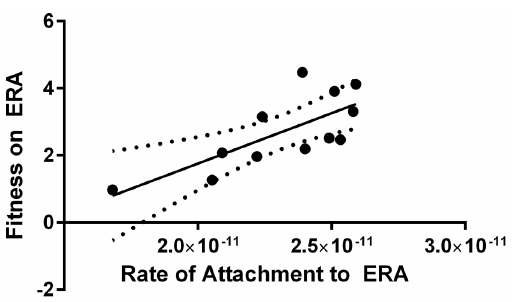
Figure 3. Mean ERA attachment rate (k) is plotted against phage 6 fitness on ERA. Attachment to ERA was correlated with fitness on ERA for 6 host range mutants. Each point is the mean of 3 replicate measurements. Dotted lines show 95% confidence